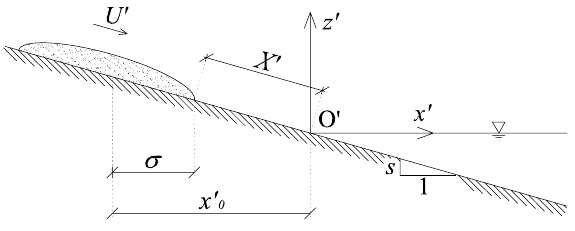
Fig. 3. Ellipsoidal slide used in the experiments of Di Risio et al. (2009). The initial position of the centroid is x 0 landslide release distance, while U 0 is the slide velocity along the incline.